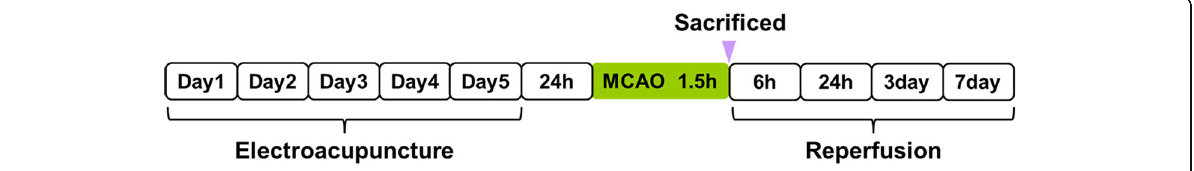
Fig. 1 Experimental design. Electroacupuncture stimulus was given at a frequency of 2/15Hz and an intensity of 1mA for 30min for 5 consecutive days. After 24h of the last stimulus, the rats were subjected to MCAO for 1.5h and were sacrificed for research at 6h, 24h, 3d, 7d after